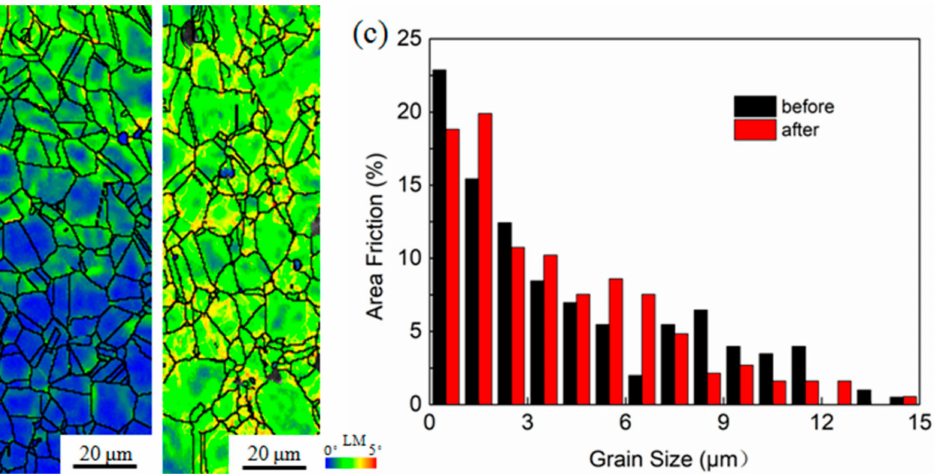
Figure 6. LM maps of the untreated samples ( a ) before and ( b ) after hot compression test, and ( c ) the corresponding grain size distribution